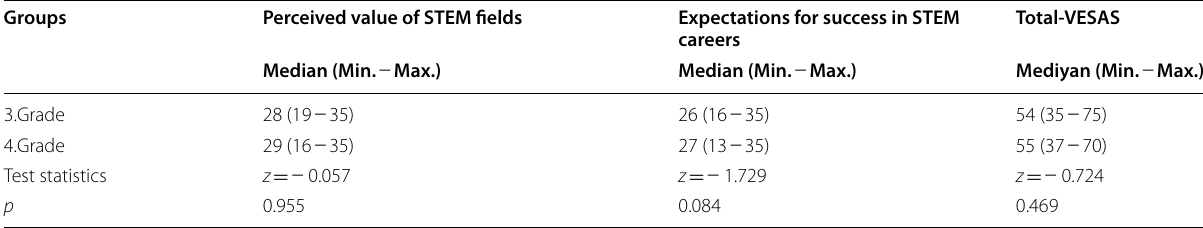
Table 2 Results of Mann Whitney U test for participants’ STEM motivation scores according to grade Groups